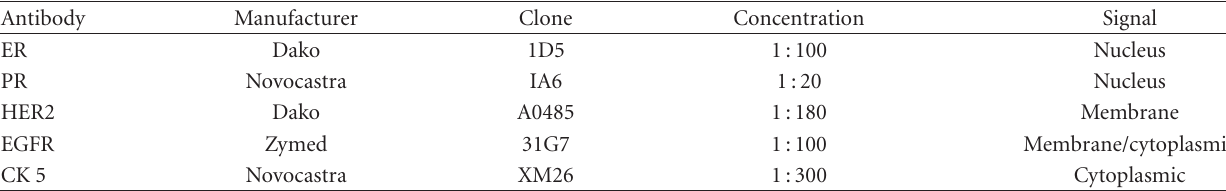
Table 2: Immunohistochemical panel of antibodies.